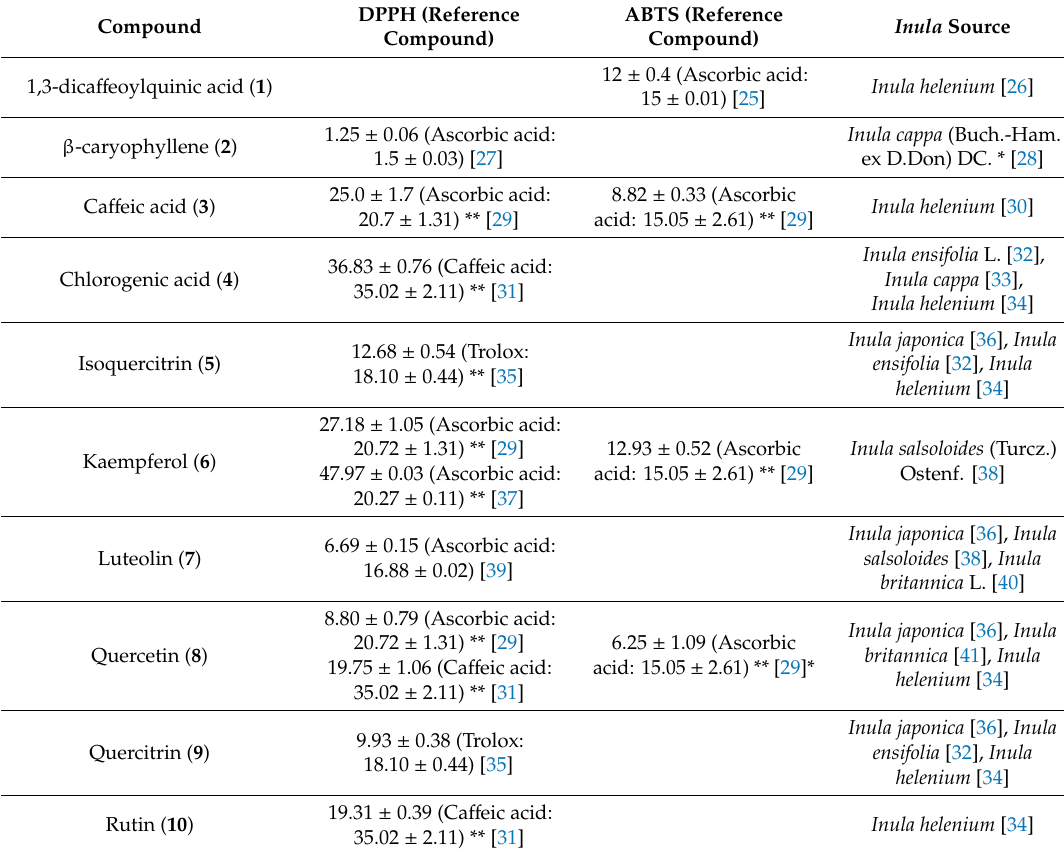
Table 1. Scavenging e ff ects of Inula secondary metabolites 1 – 10 and reference compound